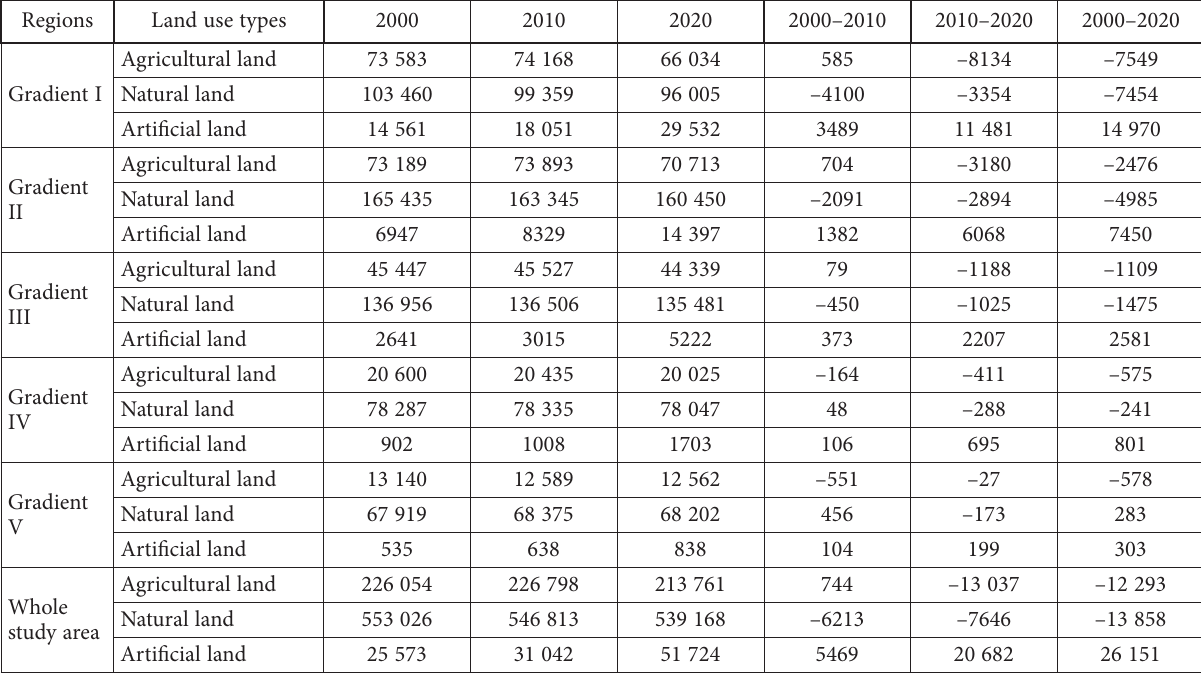
Table 7. Land use change of Guiyang (hm 2 )